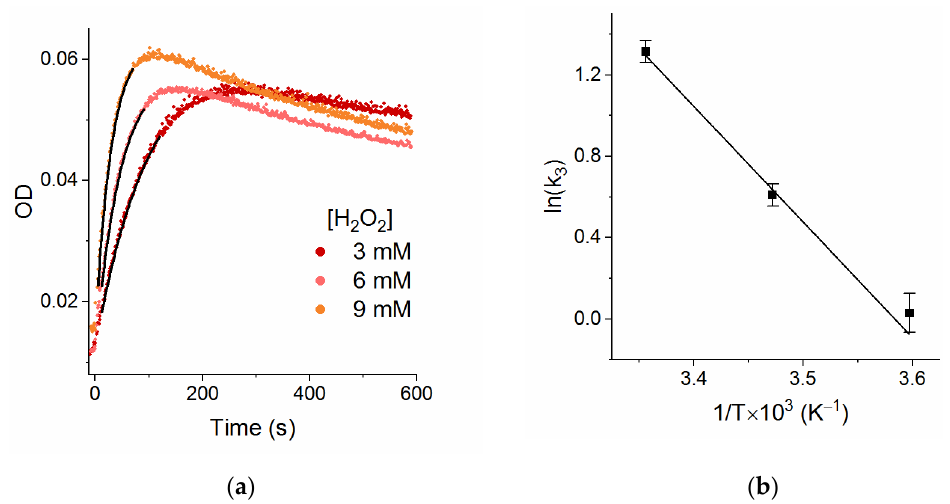
Figure 3. ( a ) Experimental (points) and theoretical (black lines) kinetic curves recorded during OSH oxidation at T = 25 °C and various hydrogen peroxide concentrations; ( b ) Arrhenius plot for k 3 rate constant with the linear fit.